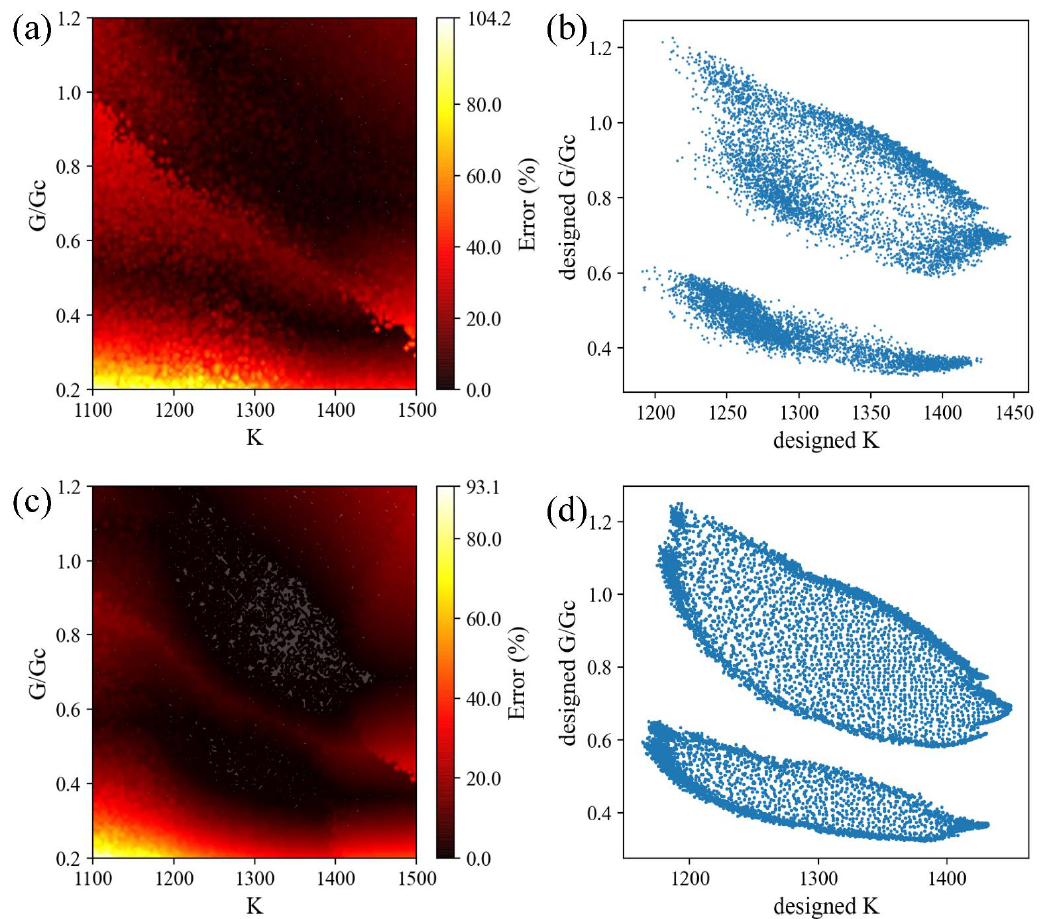
Figure 10. Comparison of CVAE and GA. ( a ) Error contour plot of CVAE ( b ) Scatter plot of properties generated by CVAE. ( c ) Error contour plot of GA. ( d ) Scatter plot of properties generated by GA. The unit of K is